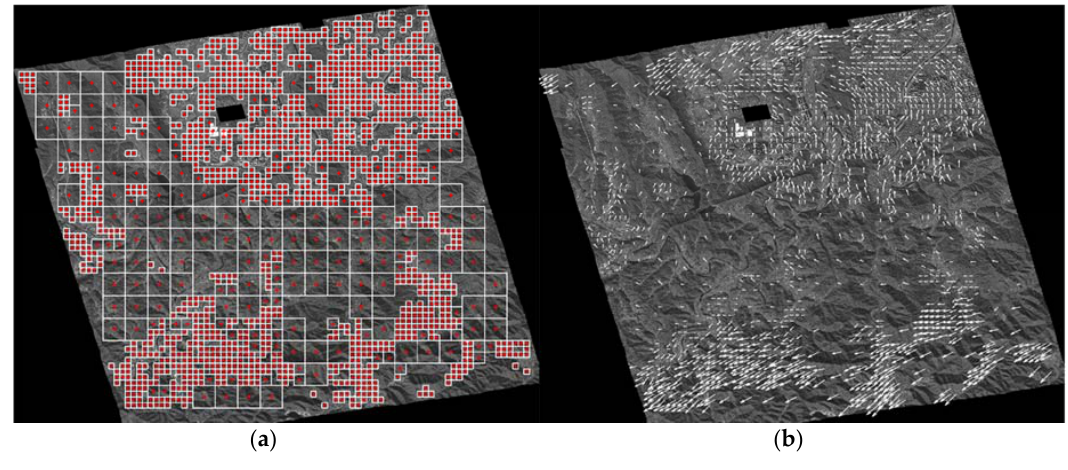
Figure 7. An example of an RN extraction result: ( a ) georegistered multi ‐ temporal images and ( b ) extracted RN from the images.